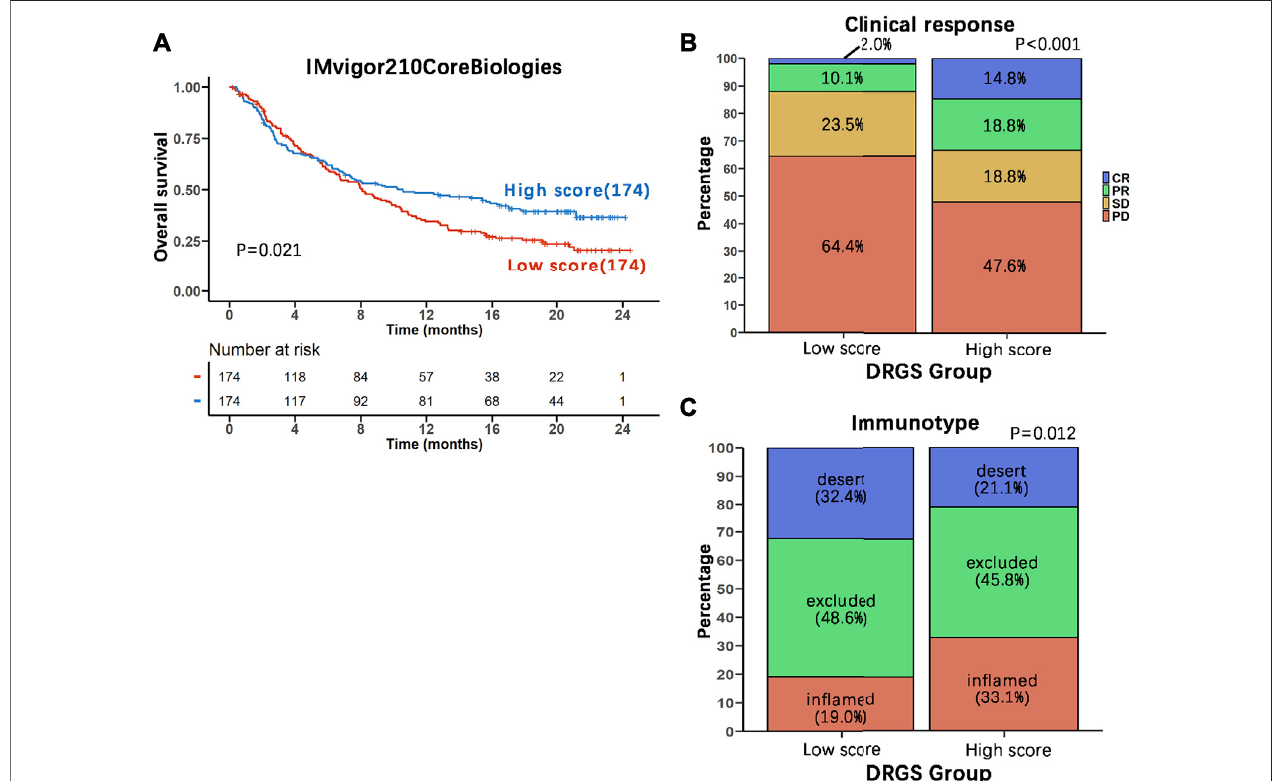
FIGURE7| Bene fi tsofimmunotherapywithPD-L1blockersinthetwoDRGSscoregroups. (A) The348patientsinIMvigor210CoreBiologieswereequallydividedintotwo groupsbasedontheirDRGSscores.Kaplan-Meieranalysisofoverallsurvivalinthetwogroupswasperformedandthesurvivalcurveswerecomparedusingthelog-ranktest(High score n = 174, Low score n = 174); (B) Comparison of the clinical response to immunotherapy between the two DRGS groups (High score n = 149, Low score n = 149); (C) Comparison of the three immunotypes between the two DRGS groups of patients using the Chi-square test (High score n = 142, Low score n = 142).